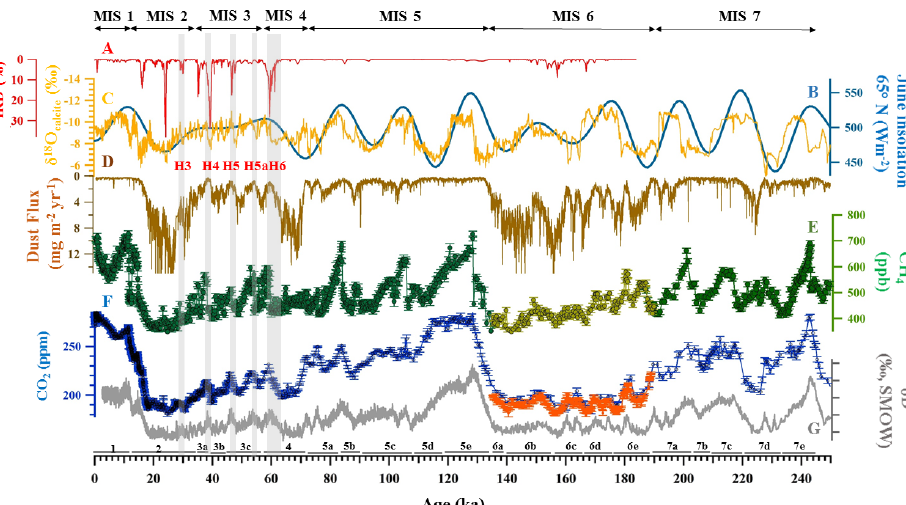
Figure 1. Proxy data over the last 250ka. (a) Ice-rafted debris (IRD) input in the Iberian Margin core MD95-2040 (de Abreu et al., 2003). (b) The 21 June insolation for 65 ◦ N (Berger, 1978). (c) The δ 18 O calcite from Sanbao cave, indicative of the strength of the East Asian monsoon (Cheng et al., 2016). (d) Dust flux in the EDC ice core (Lambert et al., 2012). (e) Published atmospheric CH 4 in EDC (dark green dots) (Loulergue et al., 2008) and a composite atmospheric CH 4 record from EDC derived in this study (light yellow dots). (f) Composite CO 2 record from the EDC ice core derived in this study (orange dots) and a published composite CO 2 record from Antarctic ice cores (dark blue dots) (Bereiter et al., 2015). (g) The δ D in the EDC ice core, Antarctica (Jouzel et al., 2007). Vertical grey bars indicate the timing of Heinrich events during the last glacial period. The event numbers are indicated at the bottom. The marine isotope substage numbers are written at the bottom (Railsback et al.,